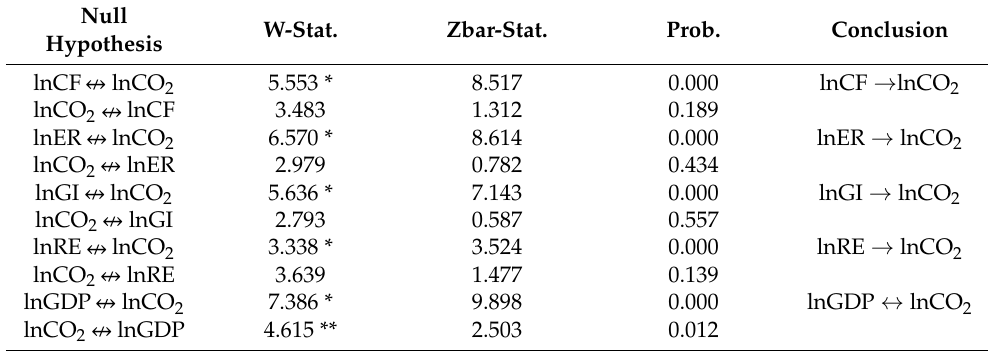
Table 10. Dumitrescu–Hurlin panel causality tests. Table 10. Dumitrescu – Hurlin panel causality tests. Null Table 10. Dumitrescu – Hurlin panel causality tests. Hypothesis Null Hypothesis Table 10. Dumitrescu – Hurlin panel causality tests. Null Hypothesis Table 10. Dumitrescu – Hurlin panel causality tests. Null Hypothesis Table 10. Dumitrescu – Hurlin panel causality tests. Null Hypothesis Table 10. Dumitrescu – Hurlin panel causality tests. Null Hypothesis Table 10. Dumitrescu – Hurlin panel causality tests. Table 10. Dumitrescu – Hurlin panel causality tests. Table 10. Dumitrescu – Hurlin panel causality tests. Table 10. Dumitrescu – Hurlin panel causality